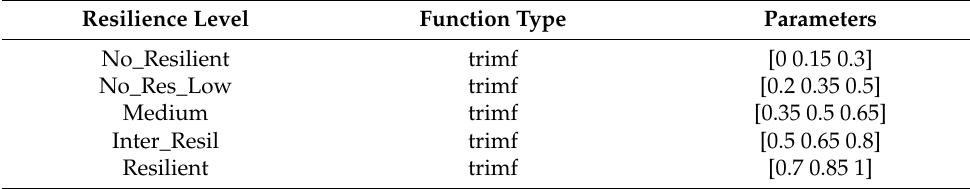
Table 8. Resilience level membership functions with five terms.